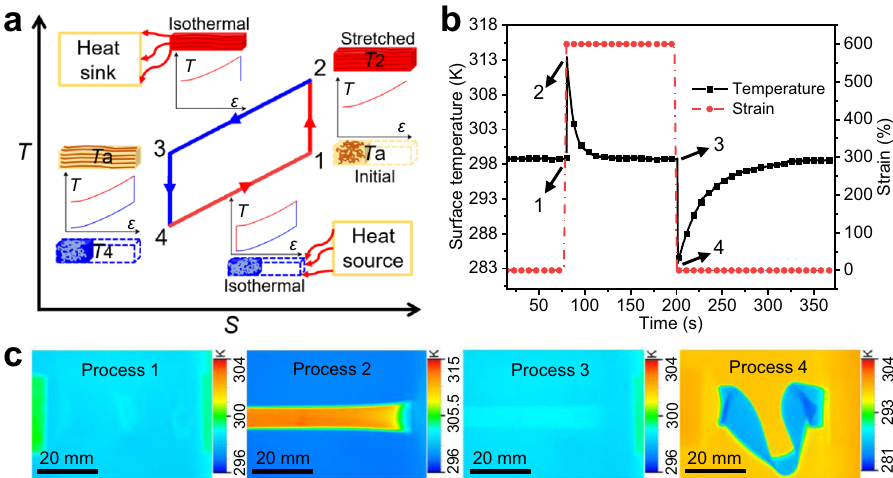
Fig. 1 E-CE cycle and temperature change of TPEs-1. a Schematic T - S diagram of the E-CE cooling cycle. The insets show the variations of the sample temperature as a function of strain. During stage 1 – 2, the sample is stretched adiabatically by a uniaxial tension, increasing the surface temperature ( T a → T 2 ). During stage 2 – 3, the strain remains constant, and the thermal entropy decreases isothermally until T = T a . During stage 3 – 4, the specimen retracts adiabatically with the unloading of the tension, further decreasing the temperature of the specimen ( T a → T 4 ). During stage 4 – 1, the thermal entropy of the material increases until T = T a . b Typical strain evolution (analogized from the displacement of the slide table) and the resulting temperature variation of TPEs-1 during a single E-CE cycle. c Infrared thermal images of different processes recorded using an infrared thermal